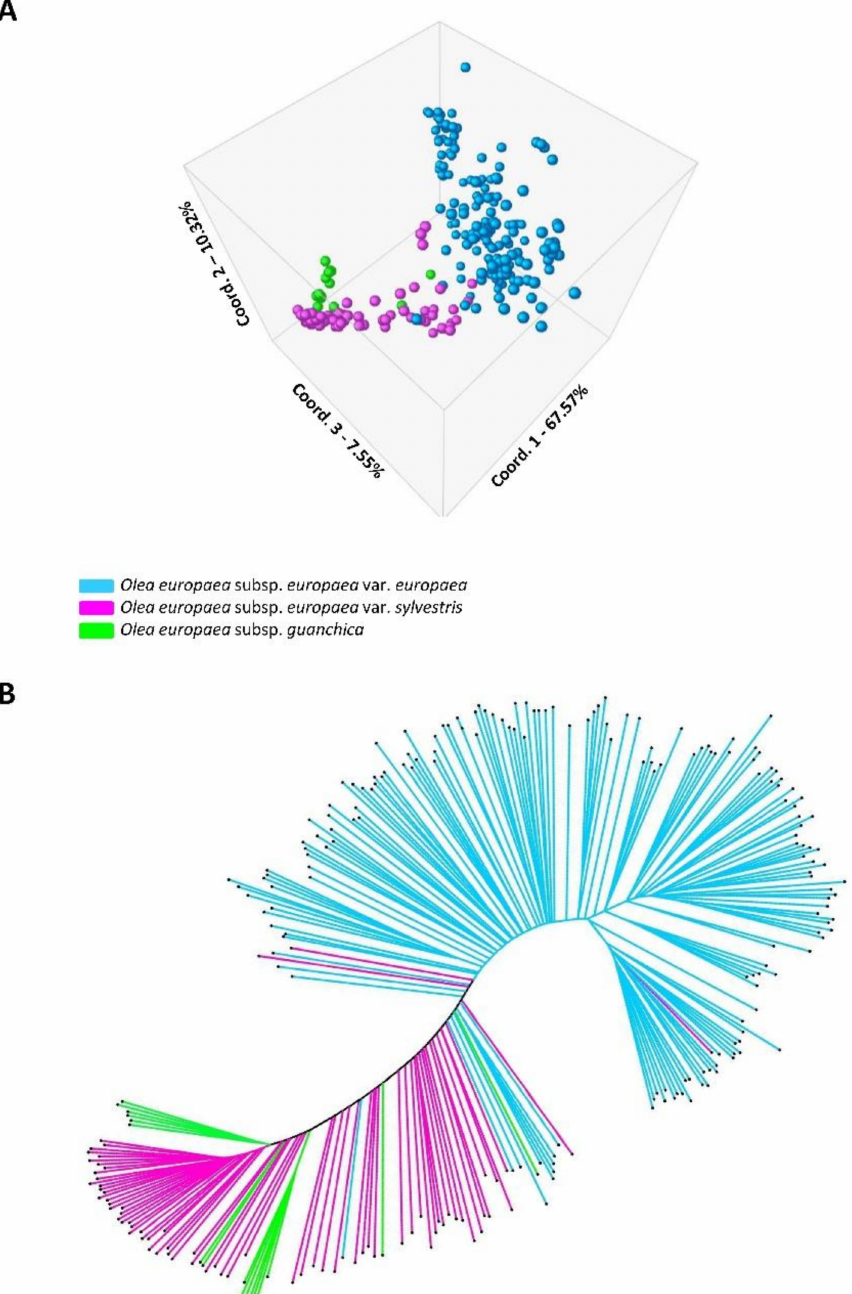
Figure 1. The Principal Coordinate (PCoA), 2- and 3-dimensional graphs, analysis based on a genetic distance matrix between the 260 olive genotypes ( A ); unrooted neighbor joining tree constructed with MEGA X of 260 olive genotypes ( B ). Colors representation, light blue—cultivated varieties; purple—oleaster; green—subsp.